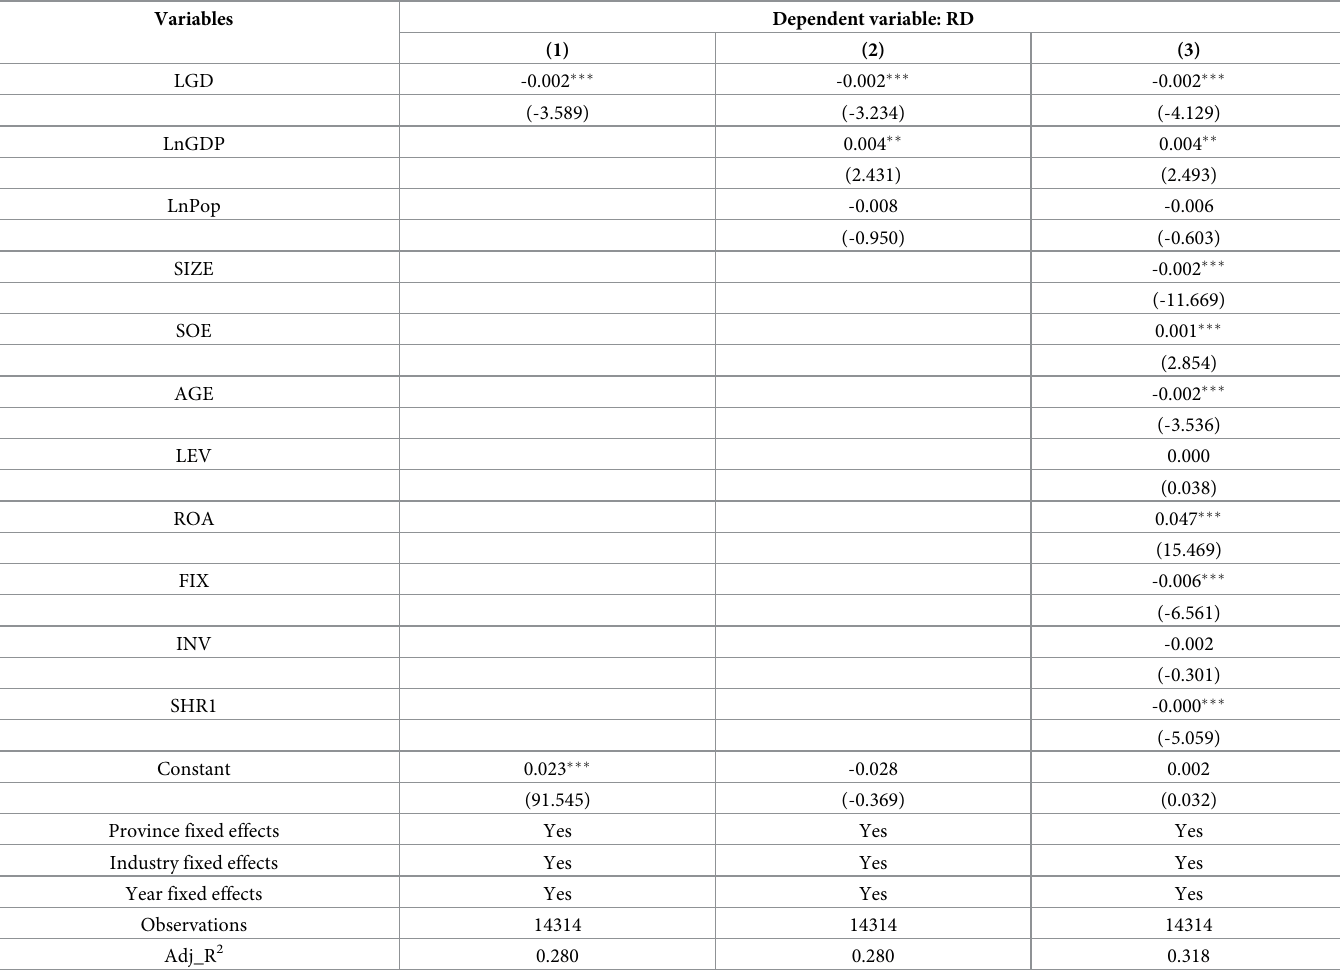
Table 3. Local government debt and corporate R&D